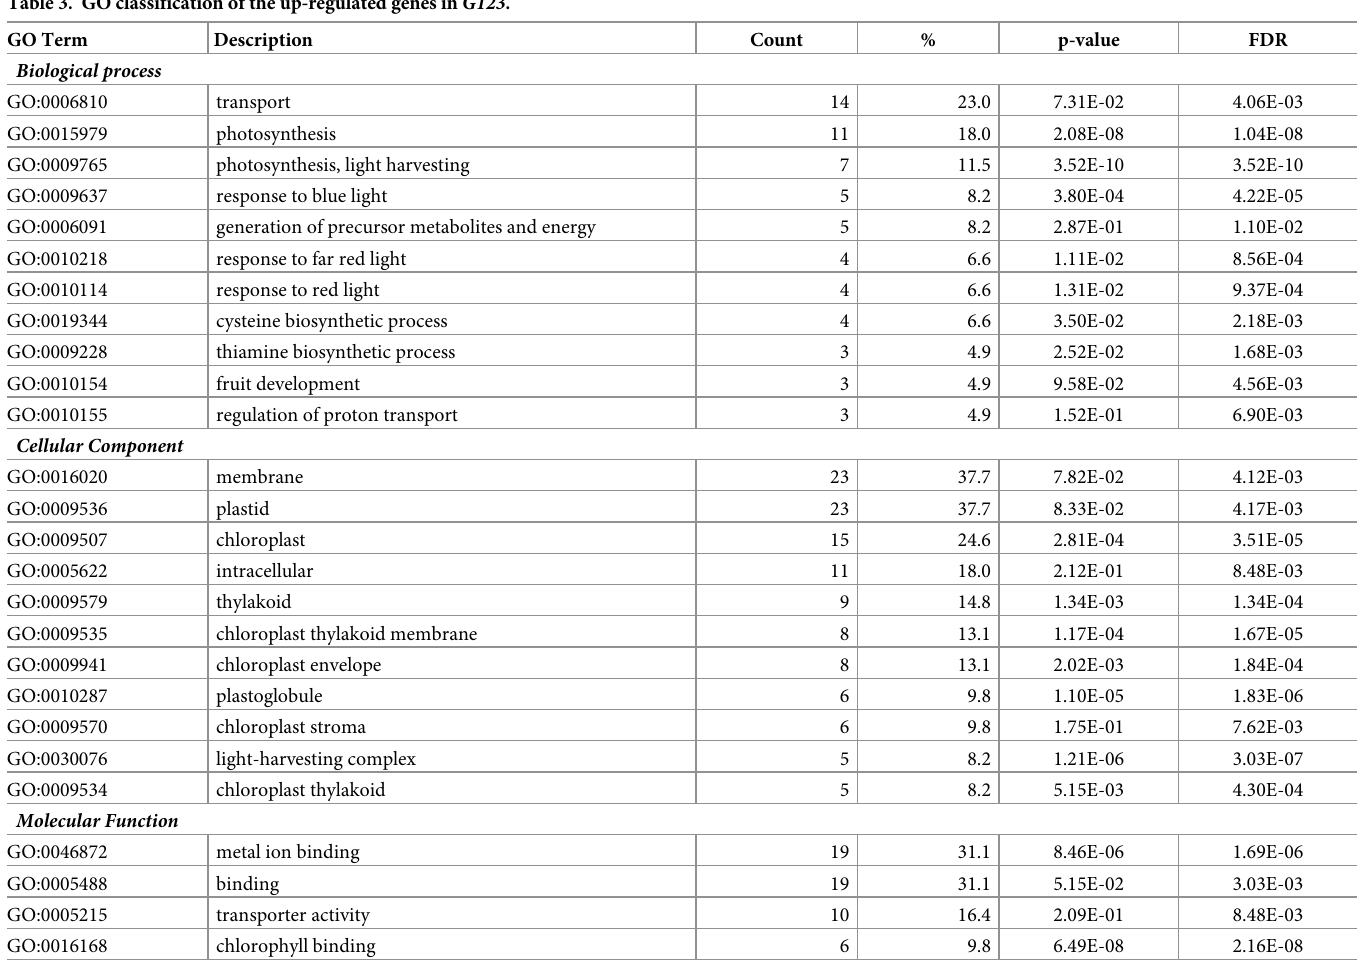
Table 3. GO classification of the up-regulated genes in G123